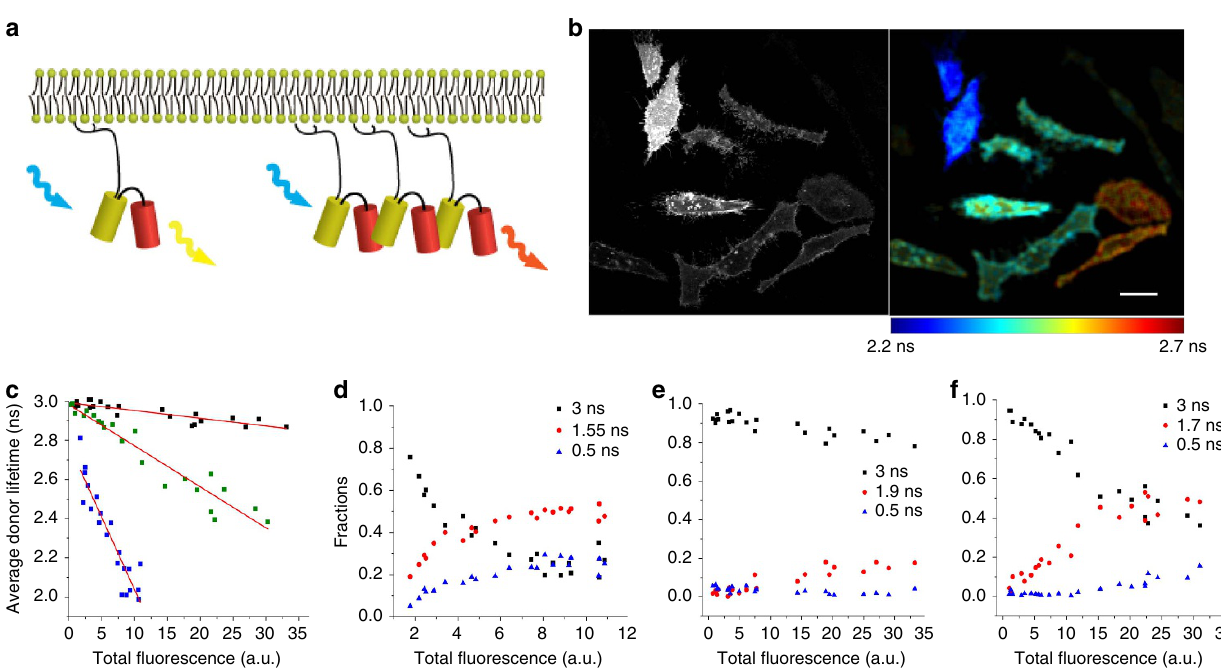
Figure 1 | Lck10-CliF is sensitive to membrane protein concentration. ( a ) Schematic drawing of CliF fused to a membrane anchor (Lck10): the single-chain FRET pair Venus-mCherry can only exhibit intramolecular FRETas a monomer (left) and also intermolecular FRET in protein clusters (right). ( b ) Fluorescence intensity (left) and average donor lifetime image (right) of HeLa cells expressing Lck10-CliF. Lifetime values were pseudocoloured according to the colour scale. Scale bar, 10 m m. ( c ) Venus lifetime in Lck10-CliF (blue), Lck10-Venus only (black) and Lck10-Venus co-expressed with mCherry-H-Ras11 (green) as a function of total (donor þ acceptor) intensity. Each data set was fitted to a straight line (red lines) yielding slopes of (cid:2) 0.075 ( R 2 ¼ 0.866), (cid:2) 0.0039 ( R 2 ¼ 0.886) and (cid:2) 0.021 ( R 2 ¼ 0.925) for Lck10-CliF, Lck10-Venus and co-expressed Lck10-Venus and mCherry-H- Ras11, respectively. ( d – f ) Venus lifetime fractions as a function of total (donor þ acceptor) intensity for Lck10-CliF ( d ), Lck10-Venus ( e ), and co-expressed Lck10-Venus and mCherry-H-Ras11 ( f ). Lifetime fractions were extracted by fitting the lifetime decay histograms of Venus to a three-component exponential decay function resulting in three distinct lifetime values, as indicated. Data in c – f were acquired for at least 30 cells per condition. More than 200 photons per pixel were recorded in the FLIM experiments.